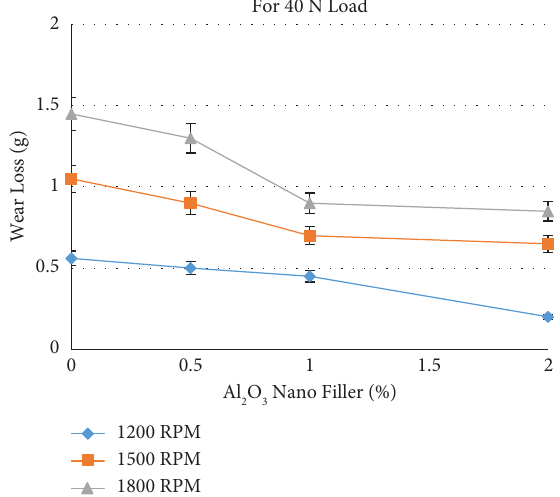
Figure 12: Wear loss of epoxy hybrid composites at 20N load. Figure